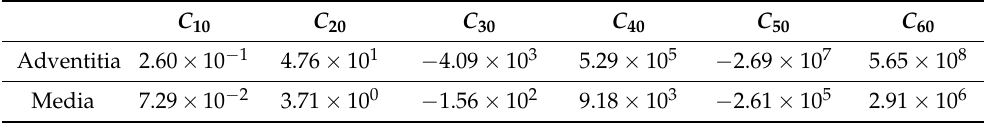
Table 1. Material models of adventitia and media: summary of the parameters of the 6th order reduced polynomial strain energy density function (Equation (3)) calibrated to fit the circumferential stress-strain curves of the fiber-reinforced model considering the in vivo status configuration as